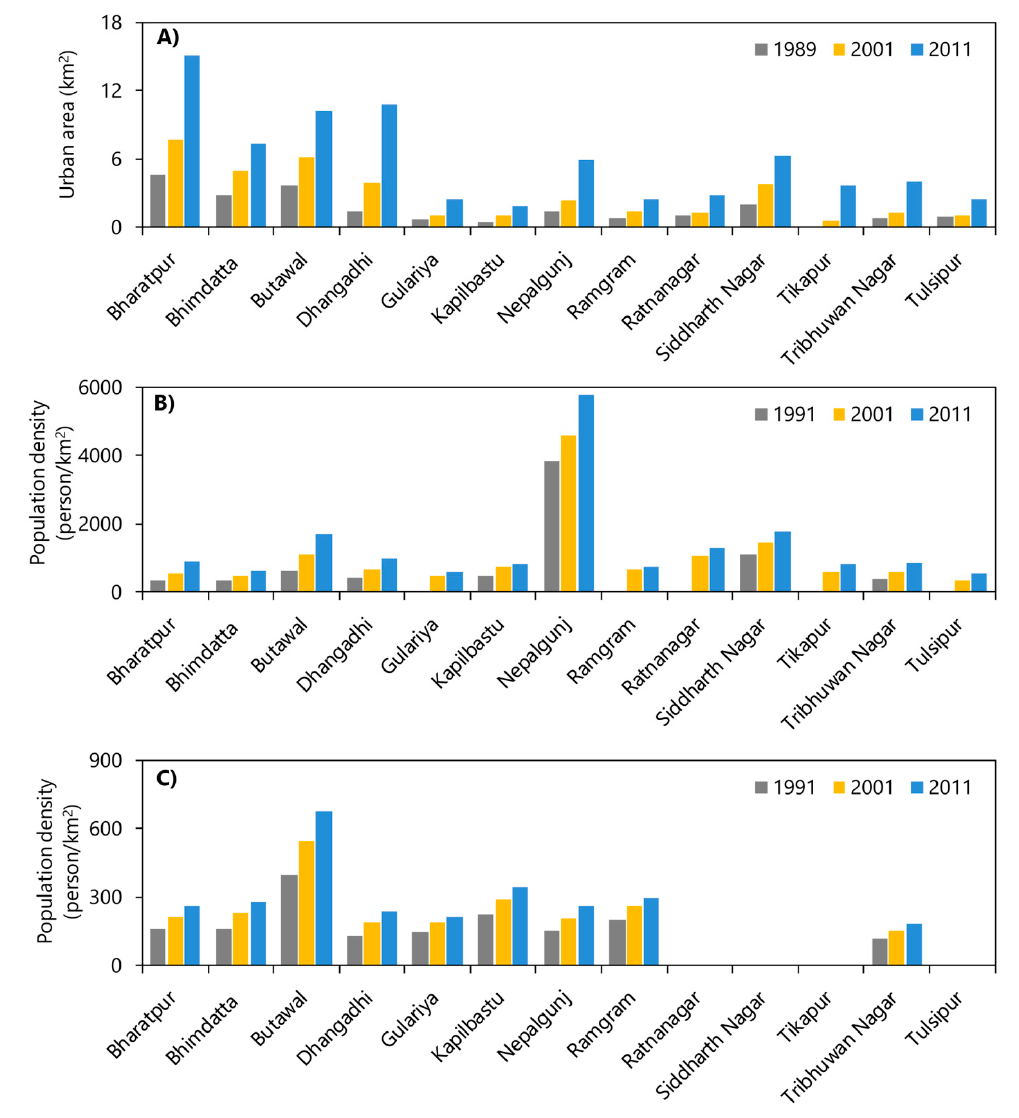
Figure 6. Demographic statistics by district. ( A ) Total urban area, ( B ) population density of urban centers, and ( C ) population density of entire districts, western Tarai region, 1991–2011.